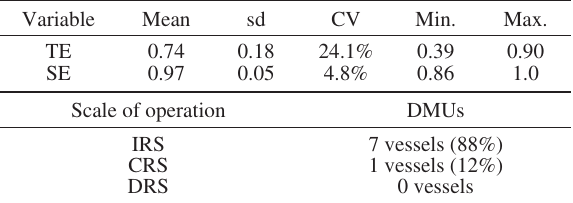
Table 7. – Descriptive statistics of technical efficiency (TE), scale efficiency (SE) and scale of operation for pesca a fresco (<60%). N=8. IRS, increasing returns to scale; CRS, constant returns to scale; DRS, decreasing returns to scale.